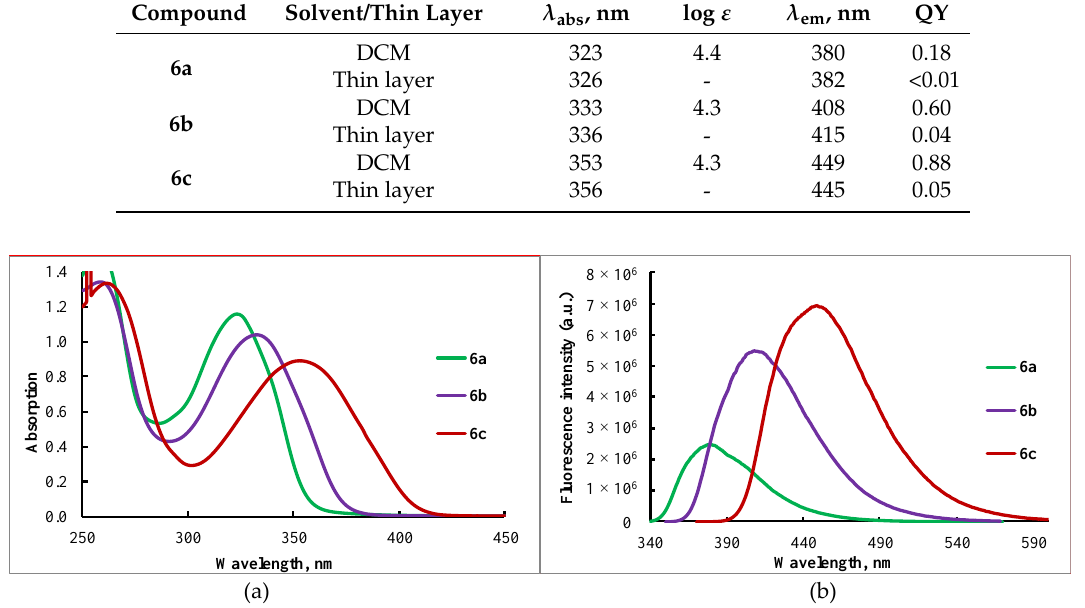
Figure 1. ( a ) Absorption and ( b ) emission spectra for 0.5 × 10 −5 M 6a – c in DCM.